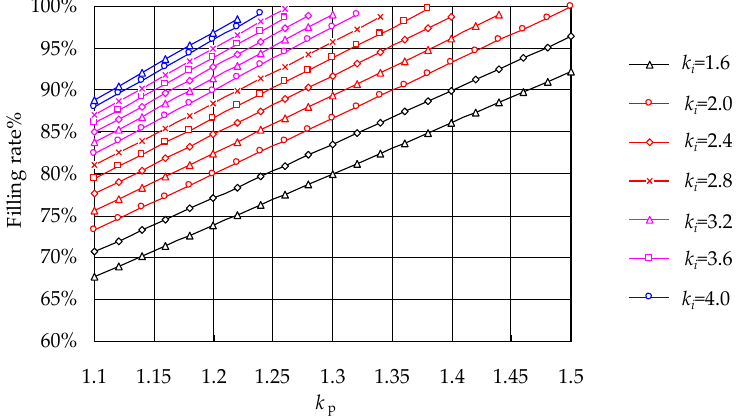
Figure 12. K p vs. Filling-rate% variation diagram for di ff erent k i .